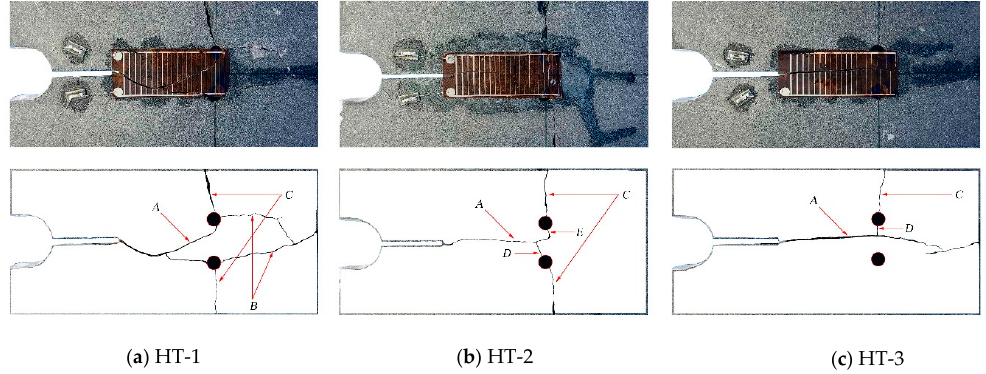
Figure 5. Crack propagation patterns of Improved Single Cleavage Semi ‐ Circle Specimen (ISCSC) specimens (a) The crack pattern of HT ‐ 1 specimen. (b) The crack pattern of HT ‐ 2 specimen. (c) The crack pattern of HT ‐ 3 specimen.